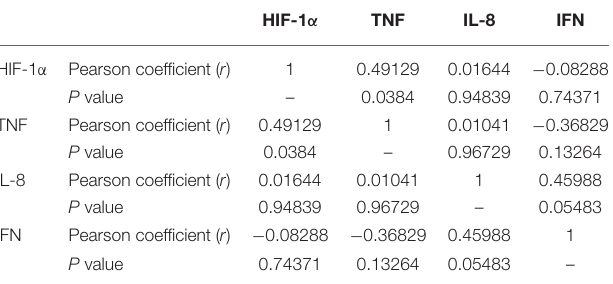
TABLE 3 | The Pearson coefficient ( r ) between HIF-1 α , TNF, IL-8, and IFN of P. fulvidraco . HIF-1 α TNF IL-8